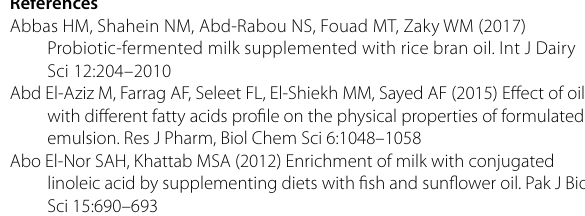
A,B,C,D letters within the same column differ significantly at P <0.05; e,f,g,h letters within the same row differ significantly at P <0.05; C, yoghurt made from ewes’ milk fed a control diet; SP, yoghurt made from ewes’ milk fed Spirulina platensis ; FO, yoghurt made from ewes’ milk fed fish oil; PC, probiotic yoghurt made from ewes’ milk fed a